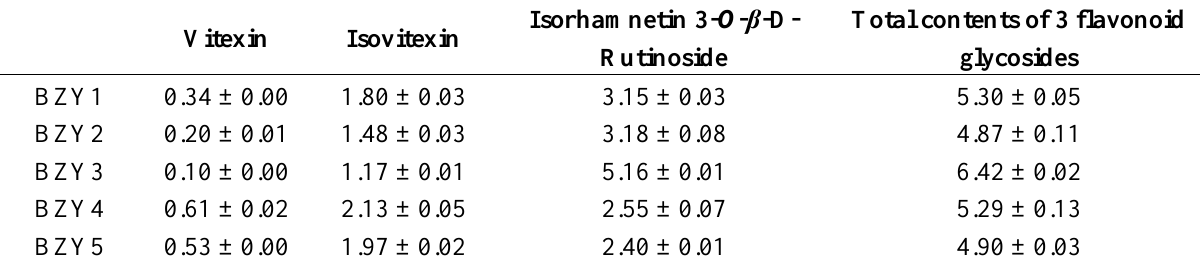
Table 3. The contents of the three flavonoid glycosides 1 – 3 (mg/g) in samples from different collections (n = 3) (Means ±